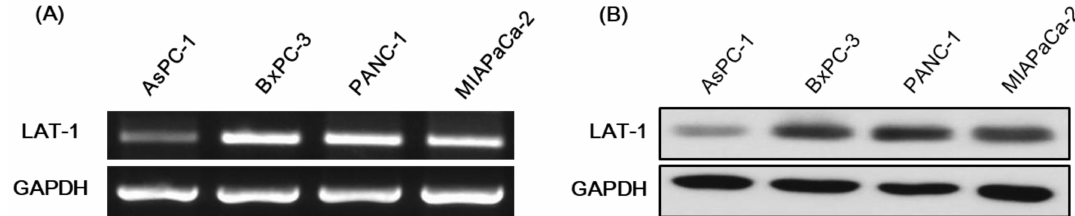
Figure 2. mRNA ( A ) and protein ( B ) expressions of LAT-1 in various pancreatic cancer cell lines (AsPC-1, BxPC-3, PANC-1, and MIAPaCa-2). Reverse transcription–PCR and Western blot were performed using gel electrophoresis after purification of DNA from cancer